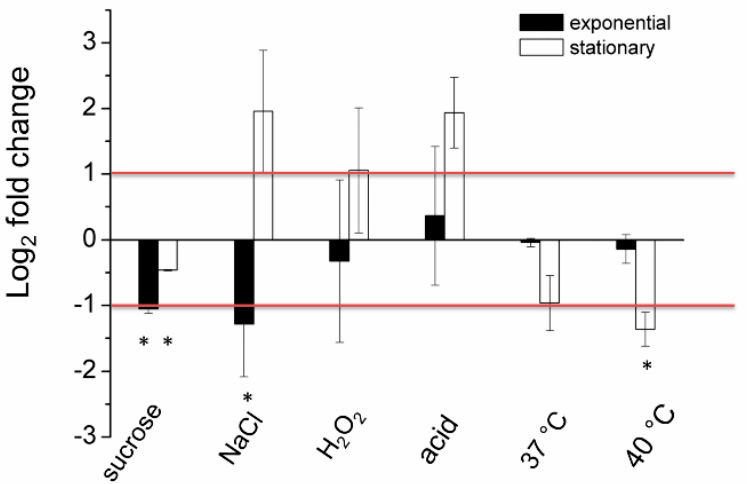
Figure 1. The relative log2 fold change of expression levels of the dsbA gene in the D. solani cells under stressful conditions analyzed via qPCR. The data correspond to the means ± standard deviation (SD) of three biological replicates with three technical repeats. The red horizontal lines denote a relative two-fold increase/decrease in the dsbA expression level. * indicates statistically significant (95% Confidence Interval) fold change in expression level according to the REST 2009 software.